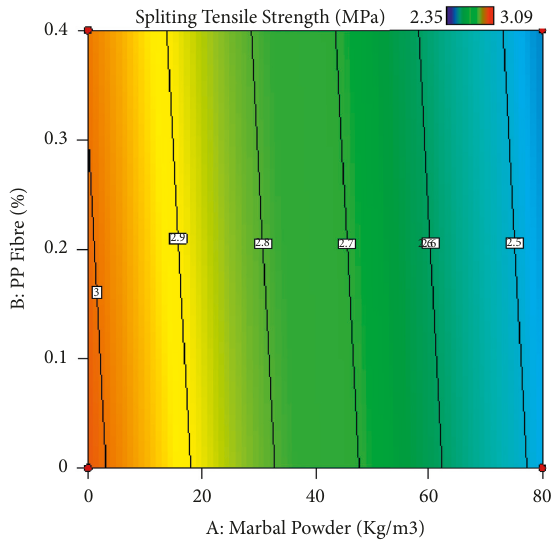
Figure 7: Compressive strength development. Figure 8: (a) 3D surface diagram for compressive strength; (b) 2D contour plot for compressive